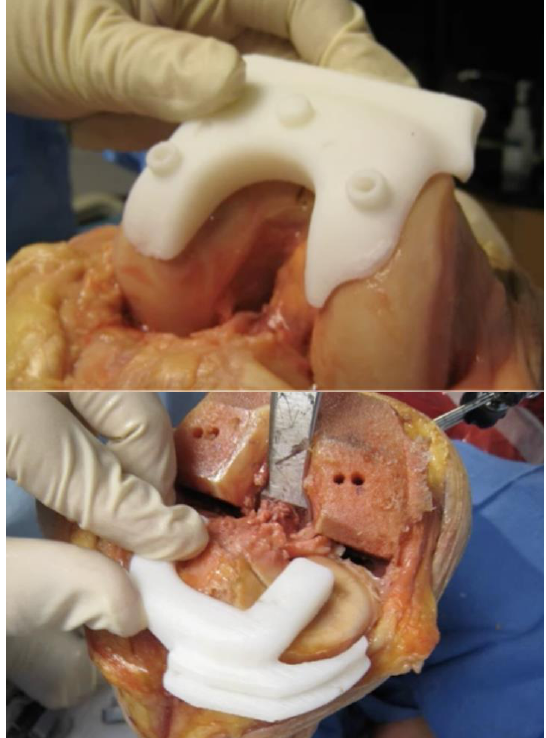
Figure 1. In the patient-specific instrumentation, the personalized cutting guides can be pinned directly into place in the femur and the tibia and contain cutting slots for a